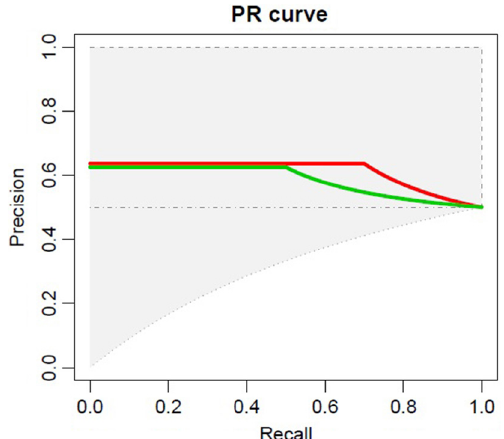
Fig. 8. The PR curves before applying the gene selection method for sample size of 10.